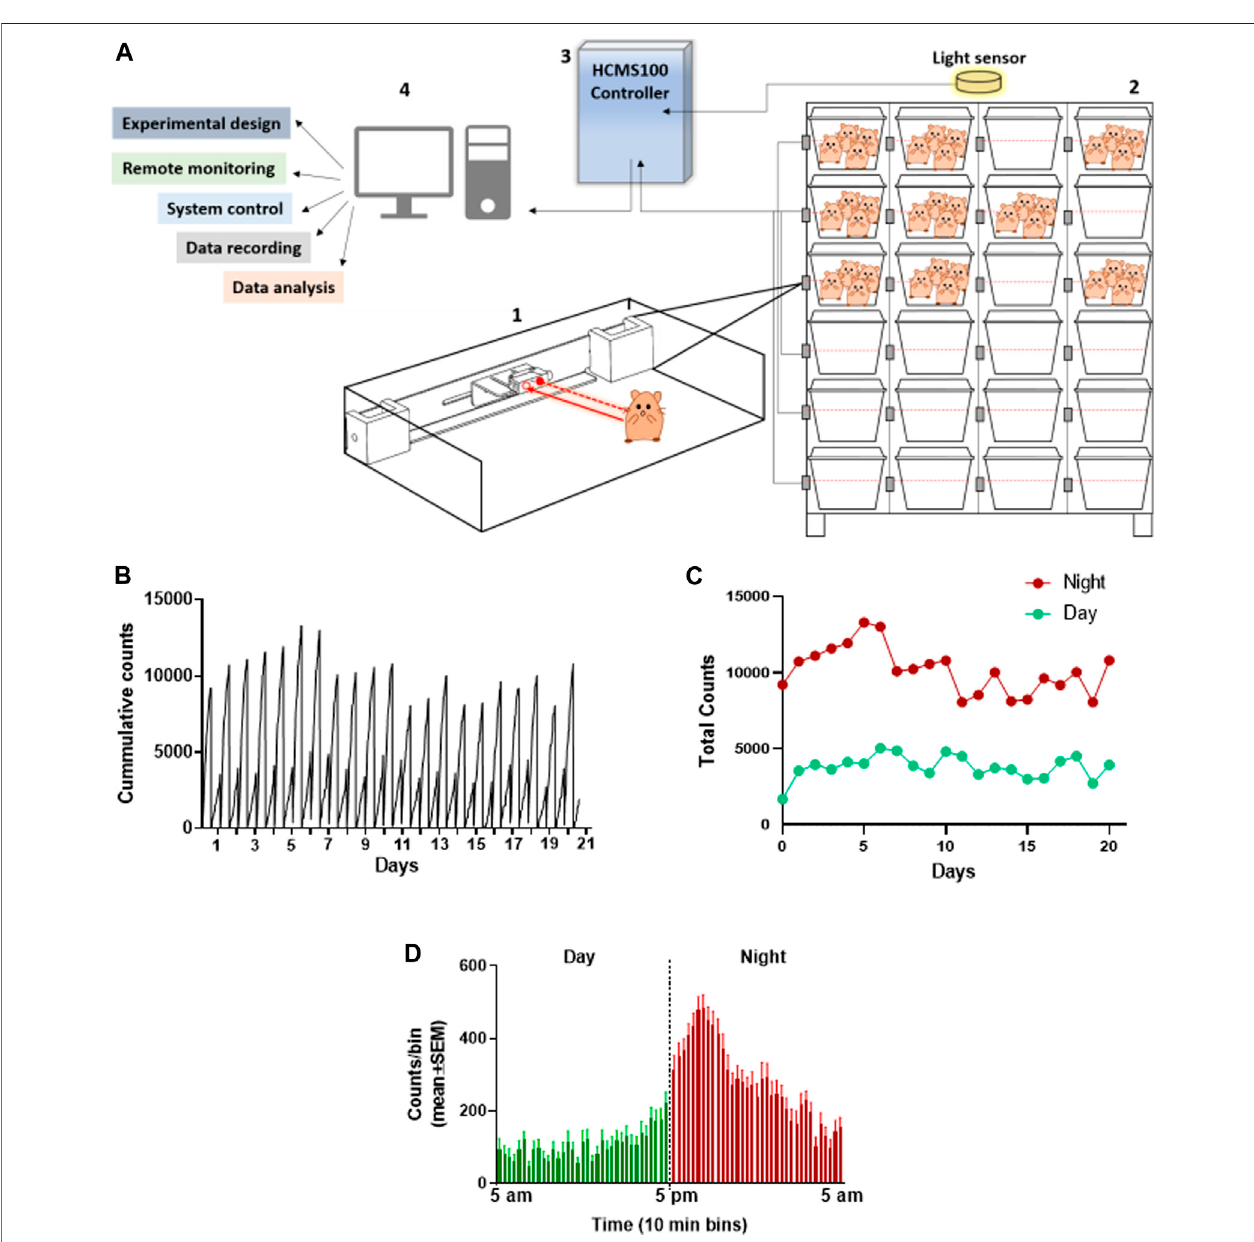
FIGURE 1 | Total activity of 4 Syrian golden hamsters in their home cage recorded continuously over 20 days using the HCMS100. (A) HCMS100 schematic outline: A single retrore fl ective sensor is located externally to each cage at the feeding zone area (1) ; multiple cages with 4 hamsters/cage are located on a cage rack wiredwithanindividualsensorforeachcage (2) .Thedetectorsareconnectedtoacommunicationcontroller (3) withalightsensortoenabledatacollectionandanalysis of circadian activity in the cage (4) . (B) Activity counts of a group of 4 hamsters in a home cage in 10 min bins with lights on from 5 am to 5 pm. Cumulative activity recordresets atlightchange(5am/5pm). (C) Totalcountsofactivityduringnighttime(5pm – 5am)vsdaytime(5am – 5pm)over20days (D) Activity countsforthesame groupofhamstersaveraged( ± SEM)in10 minbinsover20 daystodemonstratetheoverallpatternofnocturnalincreaseinactivity,peakingapproximately1 – 2 hintothe dark